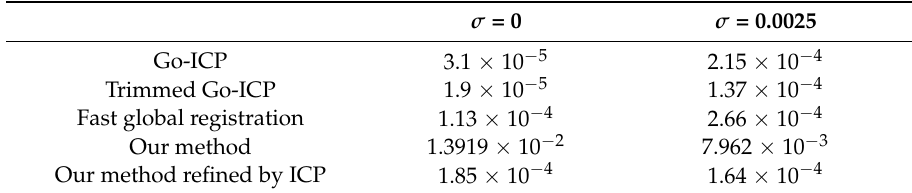
Table 1. Average Root Mean Square (RMS) error achieved by our method and dense registration algorithms on synthetic range images.